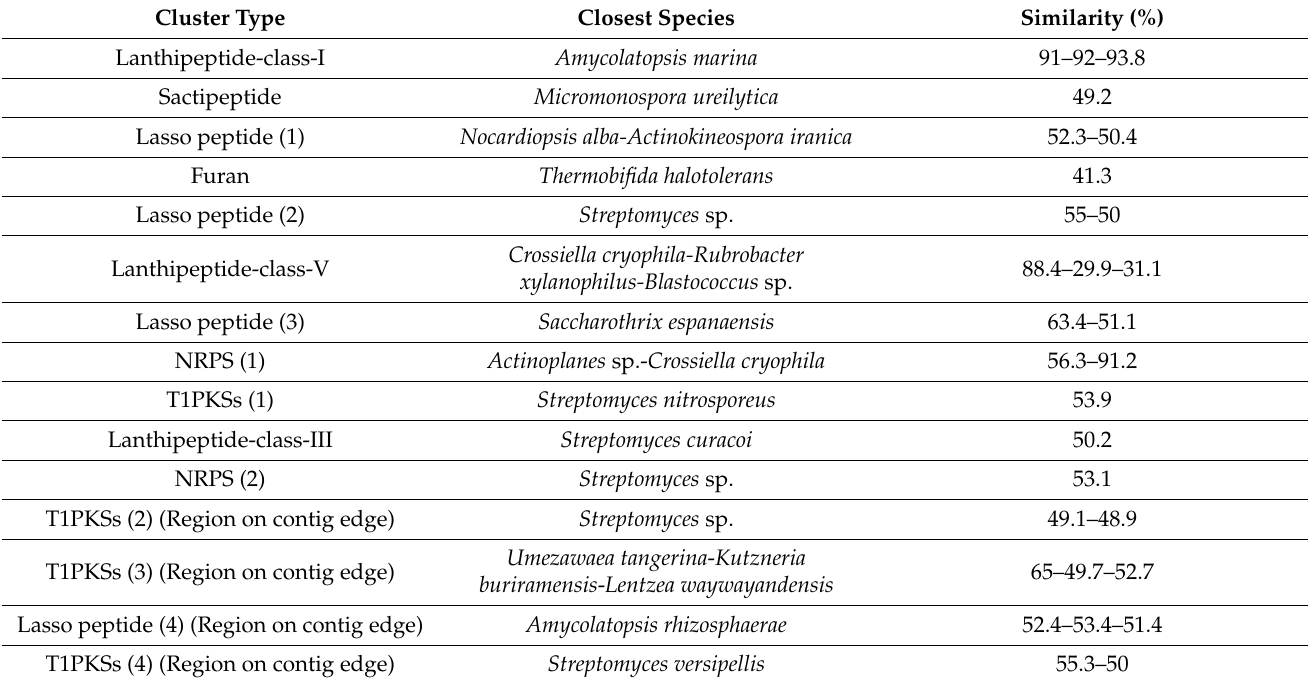
Table 2. Predicted gene clusters found exclusively in Crossiella strains Cross-1 and